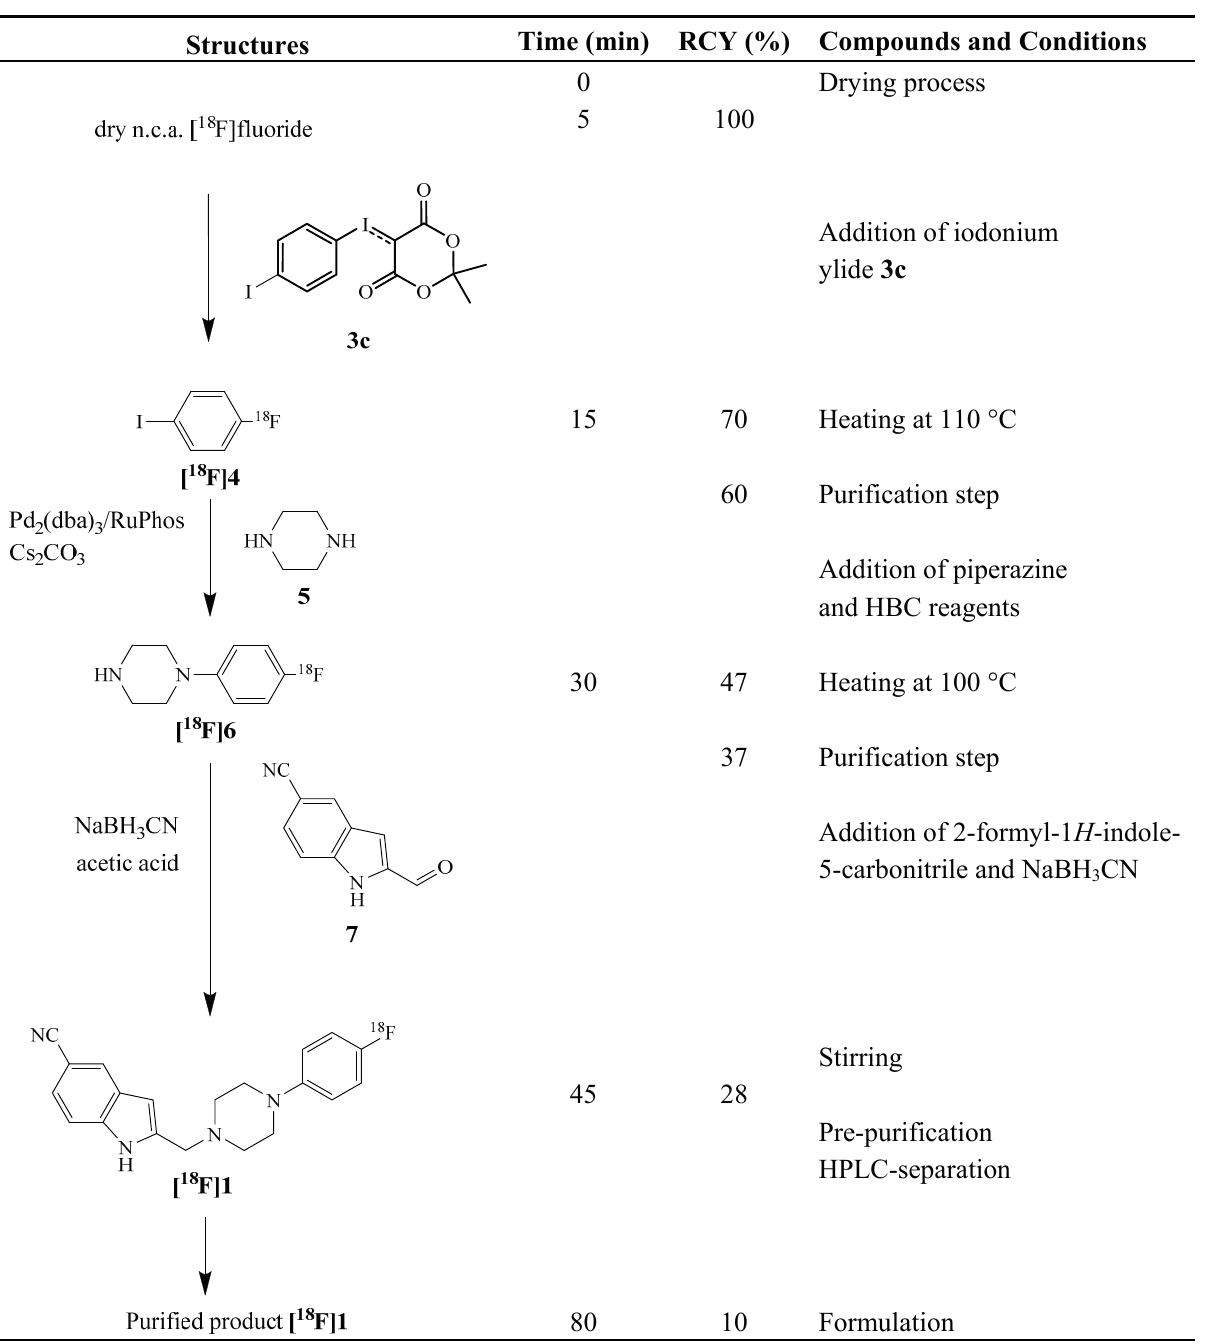
Table 2. Sequence of the two-step radiosynthesis of n.c.a. 2-((4-(4-[ 18